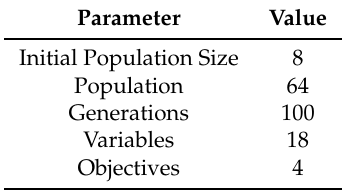
Table 1. General simulation parameters for the multi-objective evolutionary algorithm (MOEA).